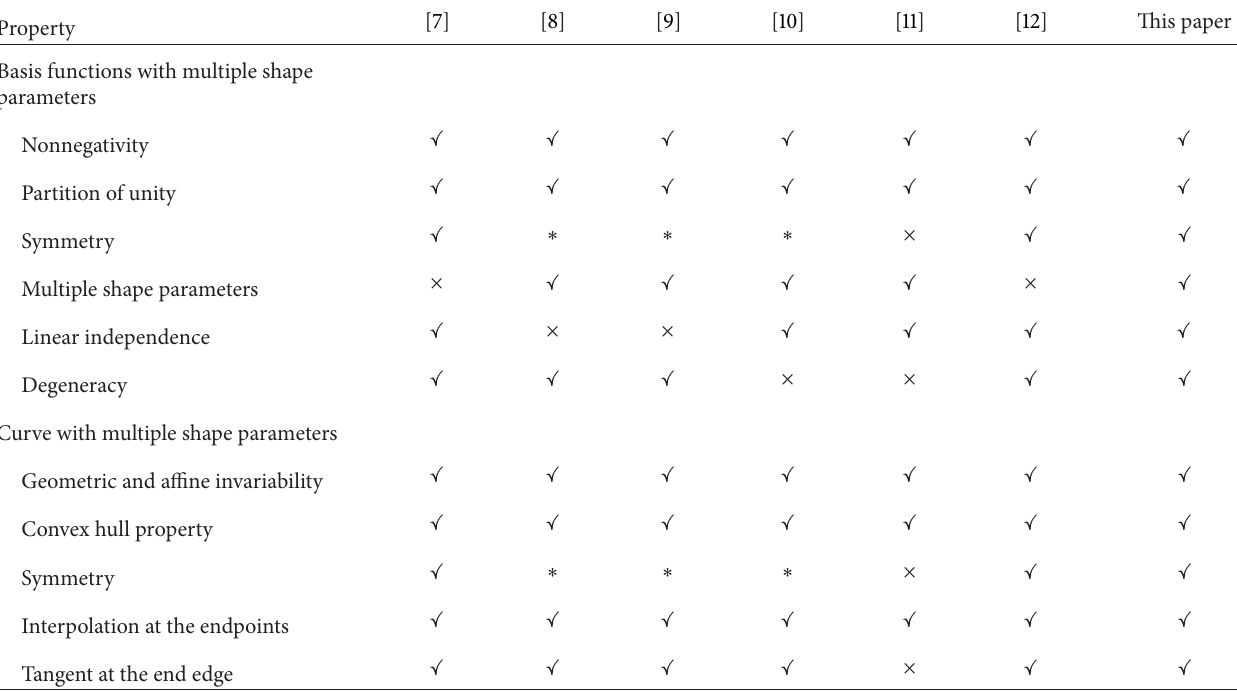
Table 1: Properties of the basis functions and the curves with shape